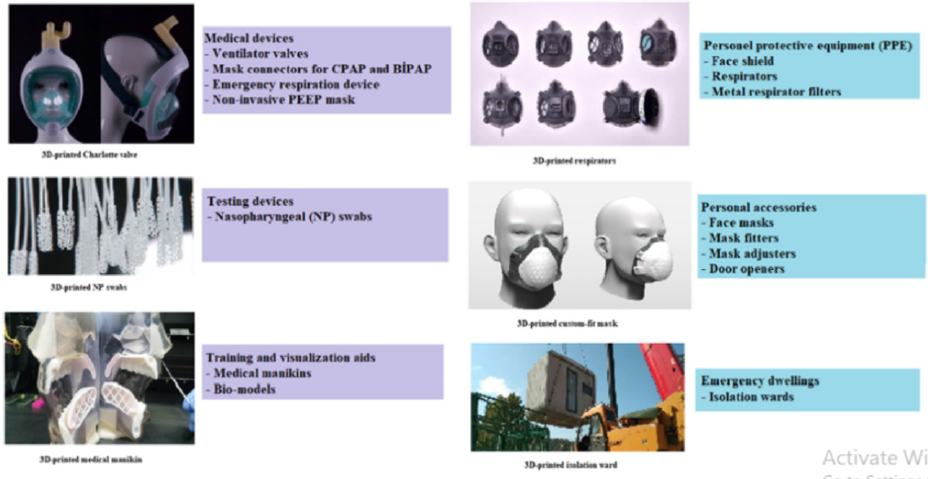
Figure 3. Equipment that could be 3D printed